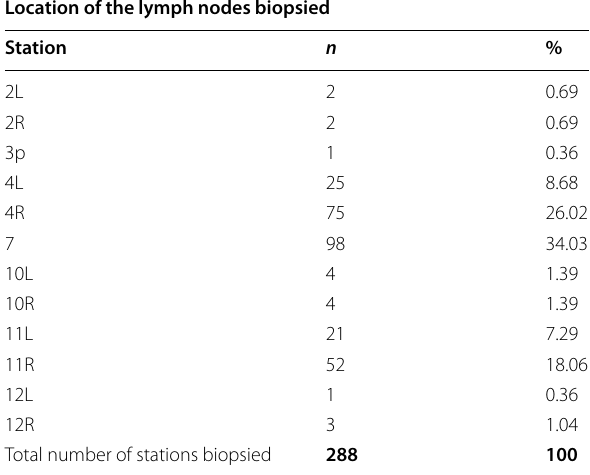
Table 5 Location of the lymph nodes biopsied according to n